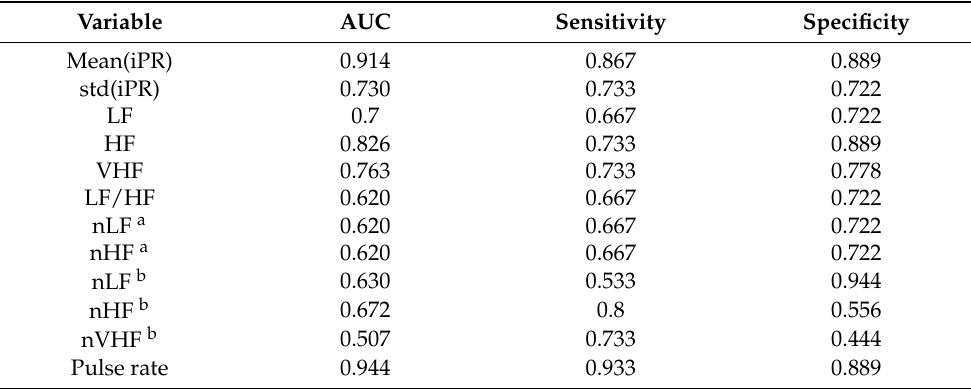
Table 4. The AUC of time and frequency domain indices of iPRV.